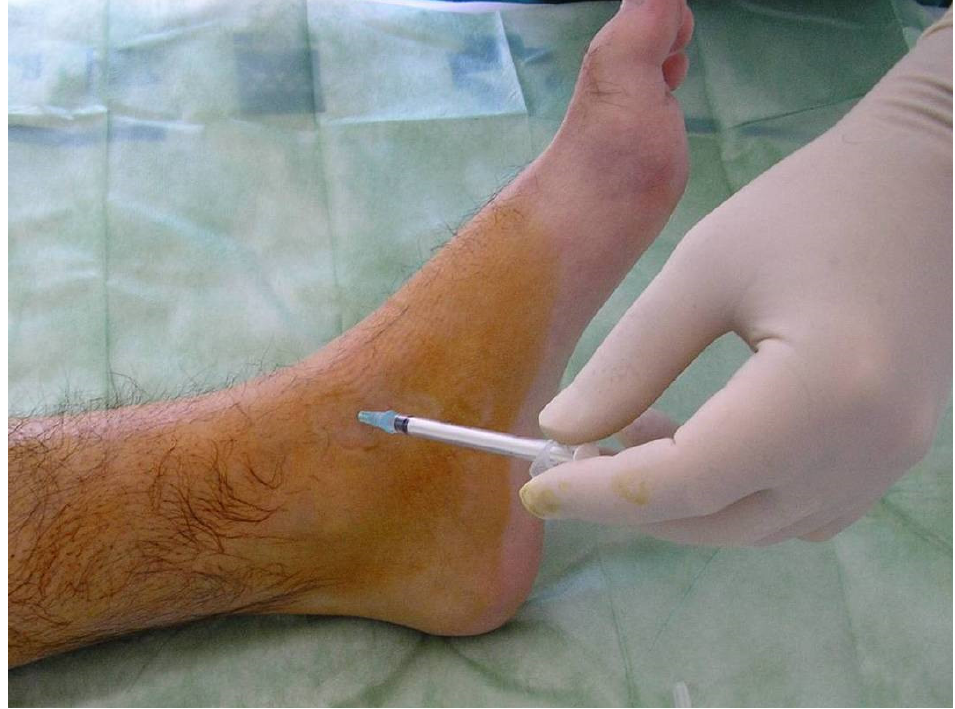
Figure 5. Radiosynovectomy (RS) of the ankle joint with Rhenium-186 in a haemophilic patients. The needle has to be removed gradually while at the same time introducing an anti-inflammatory